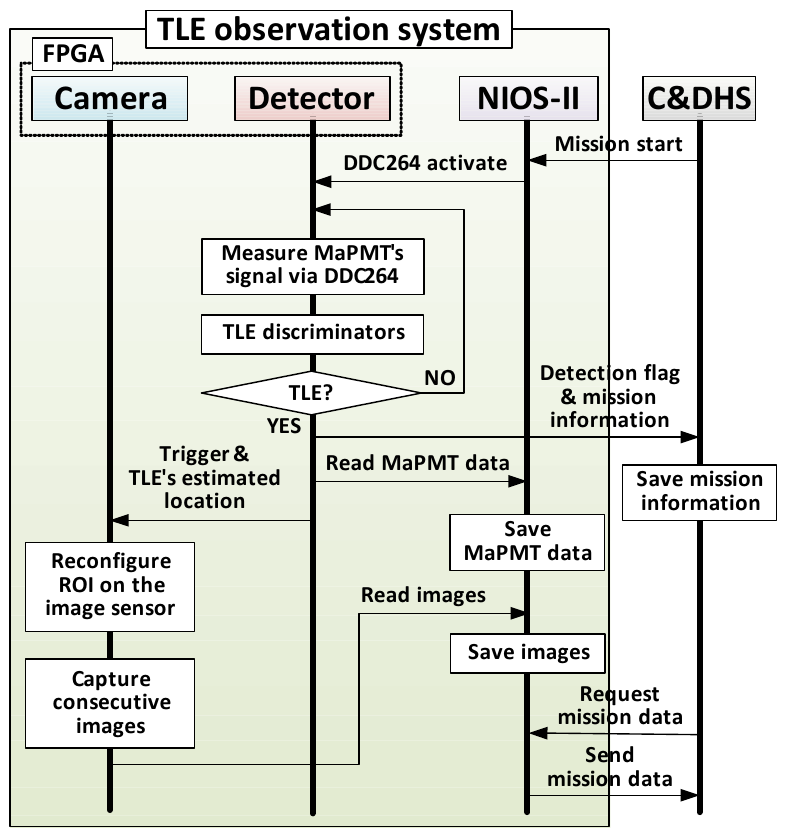
Figure 8. Operation sequence of TLE observation system. The TLE observation system conducts its mission independently after receiving the start command from C&DHS. The Nios-II manages the system and communicates with